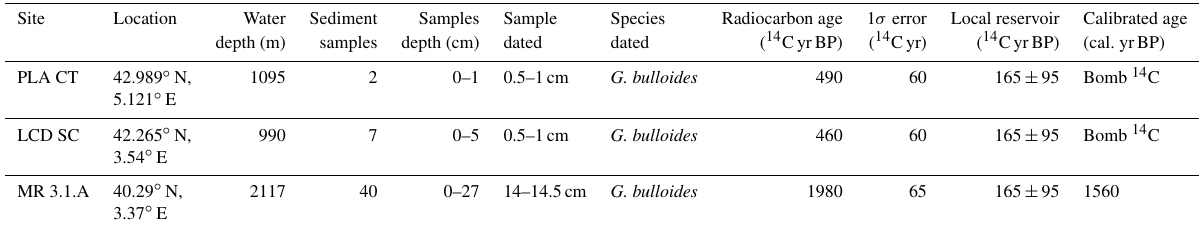
Table 1. Description of the core tops used in this study. Data for Planier core top (PLA CT) and Lacaze–Duthiers sediment core (LCD SC) are available in Heussner et al. (2006), and data concerning Menorca sediment core (MR 3.1.A) can be found in Cisneros et al. (2016). Conventional 14 C ages, 1 σ uncertainties, local reservoir, and the calibrated age have been rounded according to convention. See Sect. 3.7 for details concerning “Bomb 14